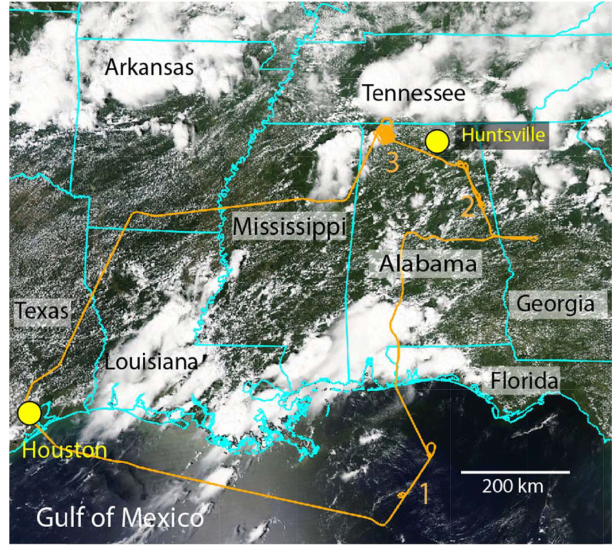
Figure A1. Flight track for the NASA DC-8 (orange) overlaid on the 12 August 2013 Aqua MODIS RGB image. Takeoff and landing were at Houston, Texas. The HSRL site at Huntsville, Alabama, is likewise marked. Coordinated curtain wall profiles with the ER-2 were conducted at labels 1 and 2, followed by the convection spiral discussed at length here at point